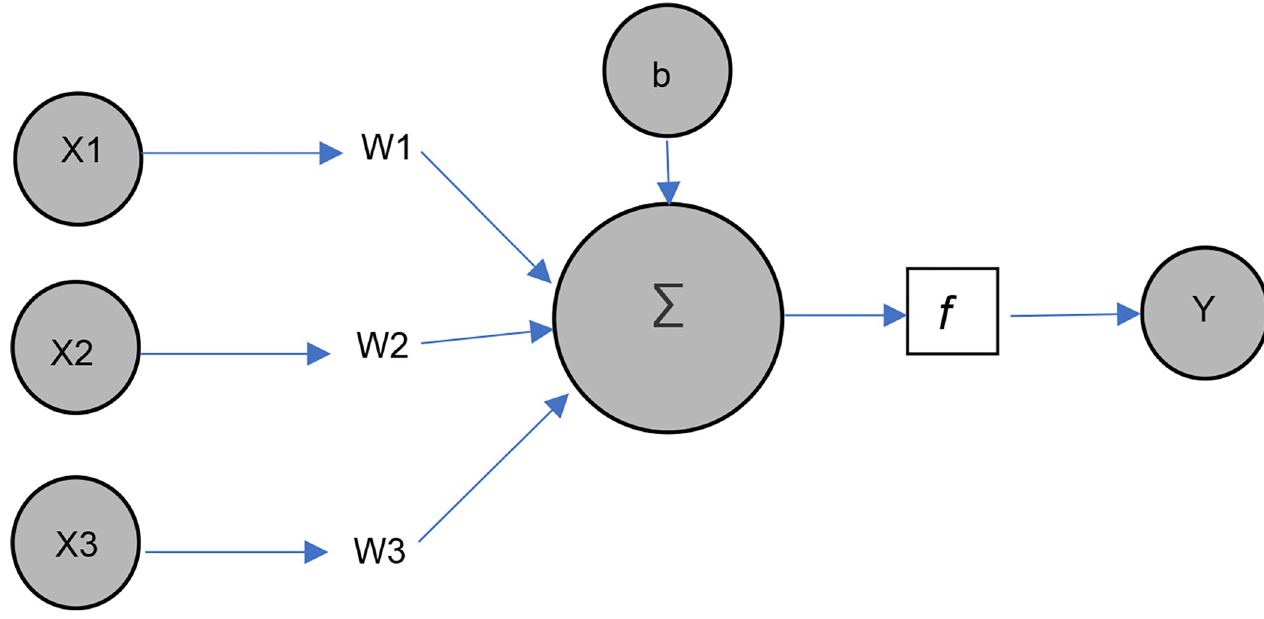
Fig 6. Simple neural network. changing the predicted output to the actual output while updating the weights according to neural network rules. Data categorization, change detection, grouping, forecasting, and predic- tions are all possible using supervised neural networks (Deep Learning) [71]. It uses hidden layers to train the existing nonlinearity between input and output variables and predicts the output [72]. Therefore, it can determine the level of significance of input variables in forecasts [68]. It is more useful for simulating spatial dynamics and identifying changes in variables [73].